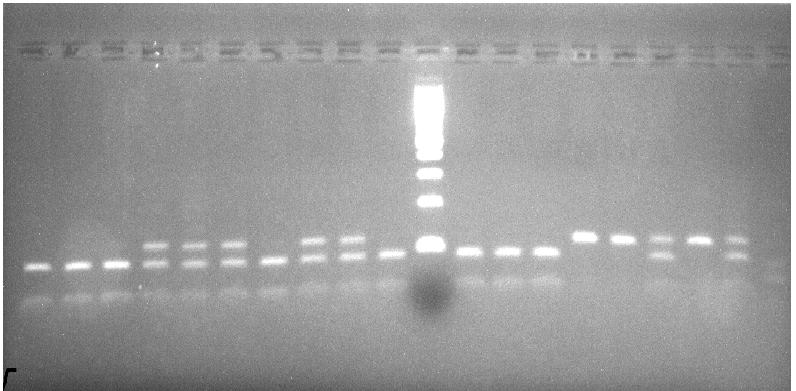
Figure 1. Results of PCR-RFLP analysis for CSN2 gene by DdeI on 3% agarose gel. Lanes 1–3, 7, 10, 12 – 14 genotype A2A2 (86 and 35 bp), Lanes 4 – 6,8,9,17,19 genotype A1A2 (121, 86 and 35 bp), Lanes 15,16,18 genotype A1A1 (121 bp), Lane 11 Ladder 100 bp, and Lane 20 Negative